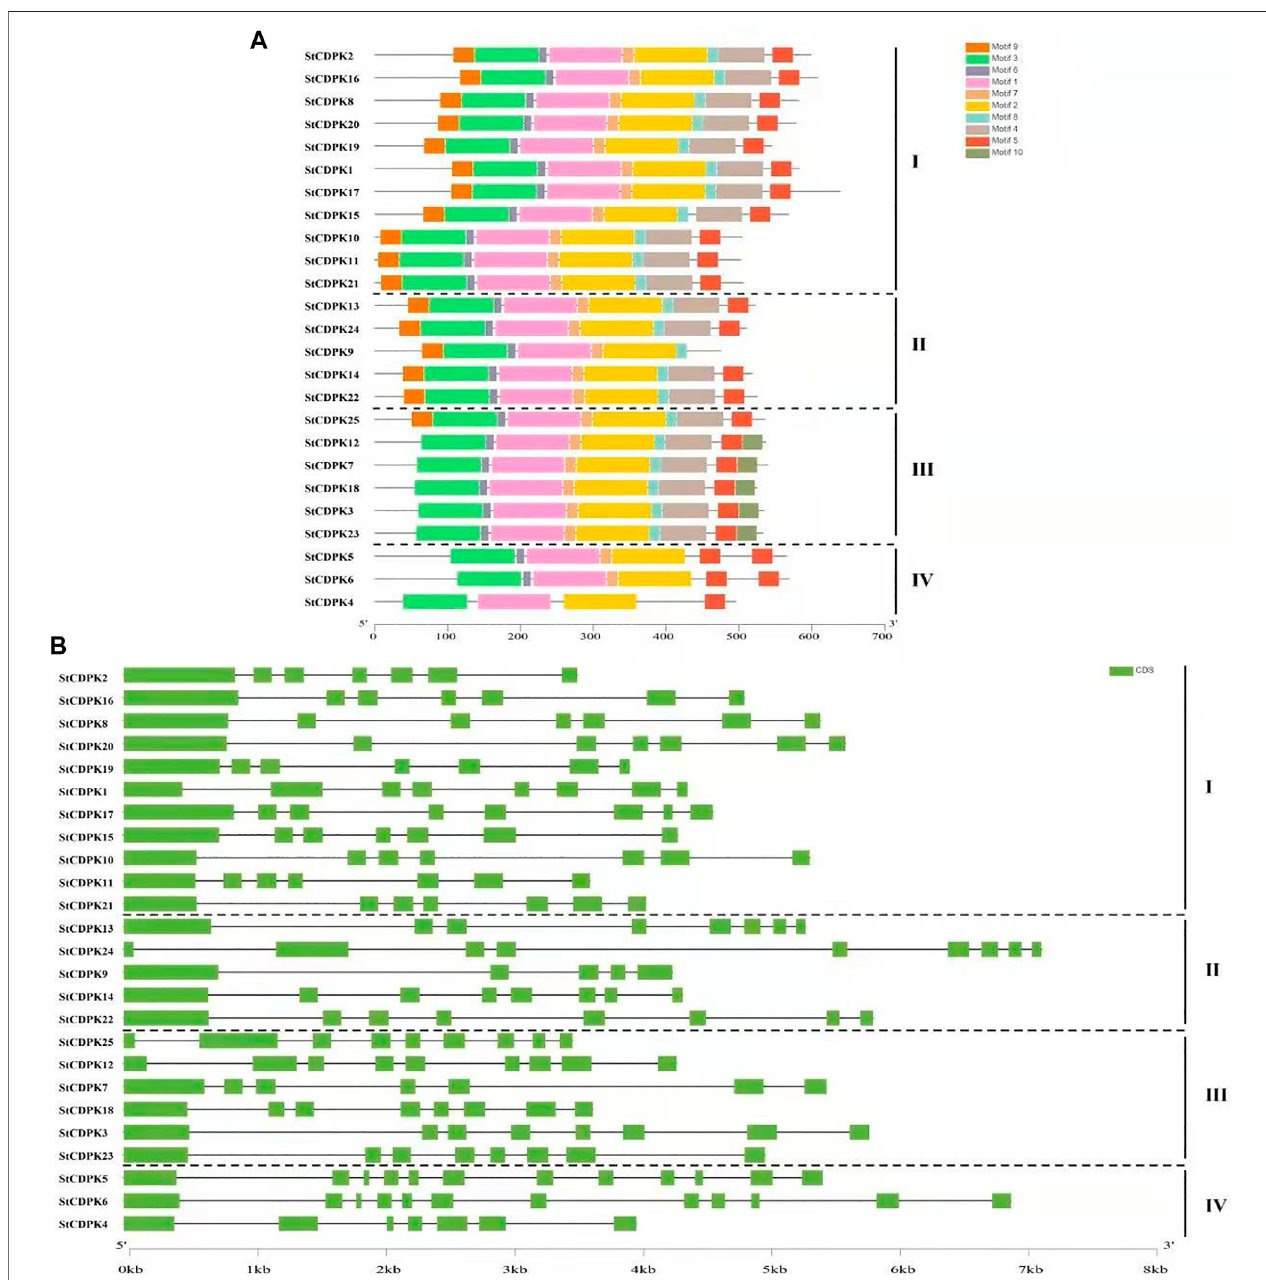
FIGURE 3 | Gene structure and conserved protein motif of StCDPKs gene family members. (A) The conserved motifs of StCDPK proteins were discovered using the online searching tool MEME (http://memesuite.org/tools/meme). Different colors were used to indicate the conserved motifs. (B) Structural organization of exon/ intron of the 25 potato CDPKs. Exons are represented by green boxes and black lines for